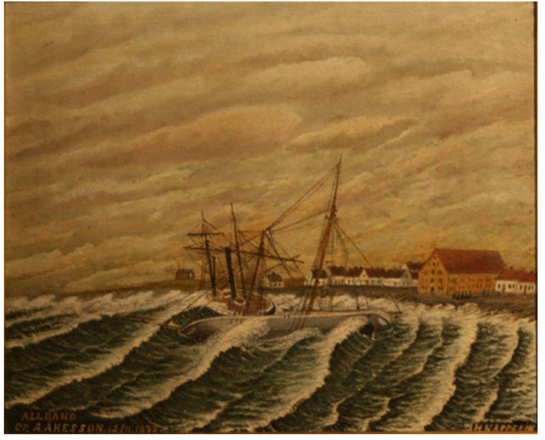
Figure 4. Oil painting of the ship Albano being wrecked in Simrishamn, painted by H.